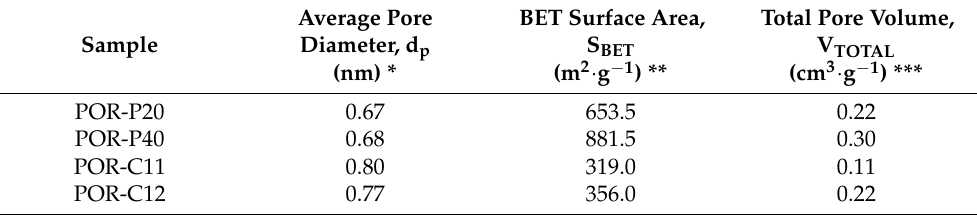
Table 3. BET results for all the produced ACs (correlation coefficient = 0.99) 1 .